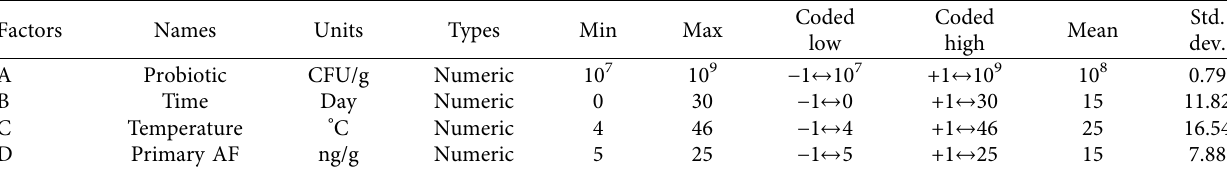
Table 2: Efective factors in